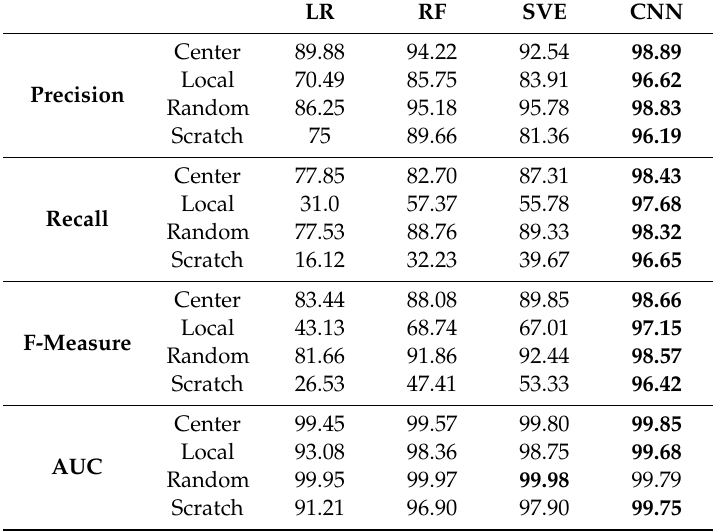
Table 3. Classification results of various methods.